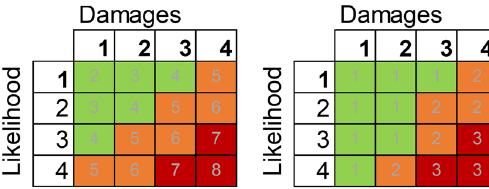
Fig. 3 Examples of risk matrix implementation. Left: default construction and acceptability thresholds of 5 and 7. Right: user own rating